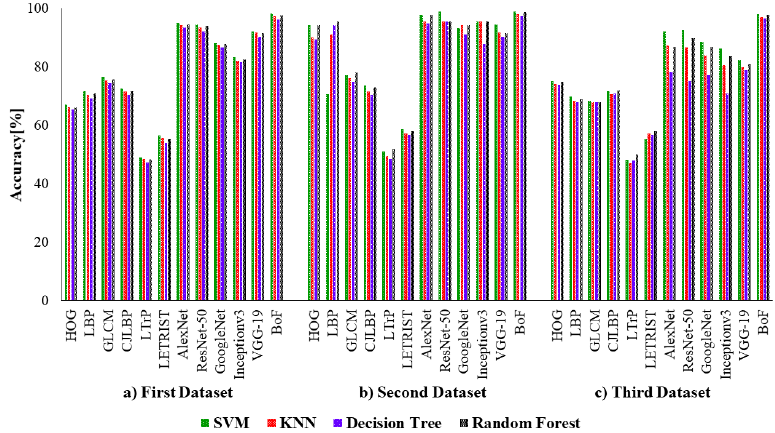
Figure 10. Comparison of accuracies of different classifiers for all